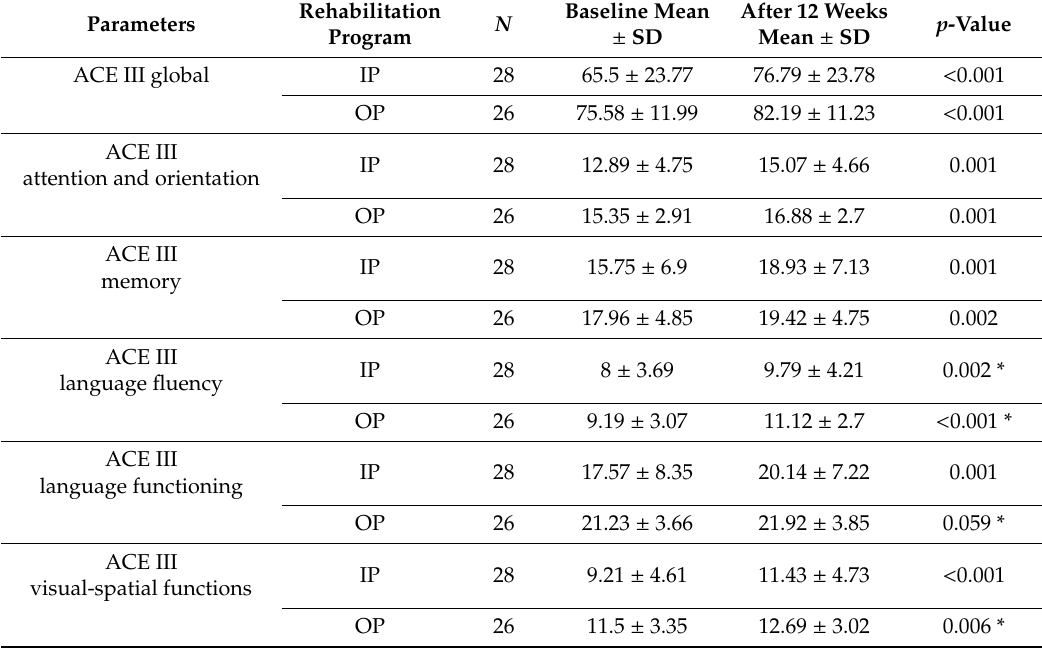
Table 4. Analysis of the cognitive functioning results before and after rehabilitation treatment in BT inpatients and